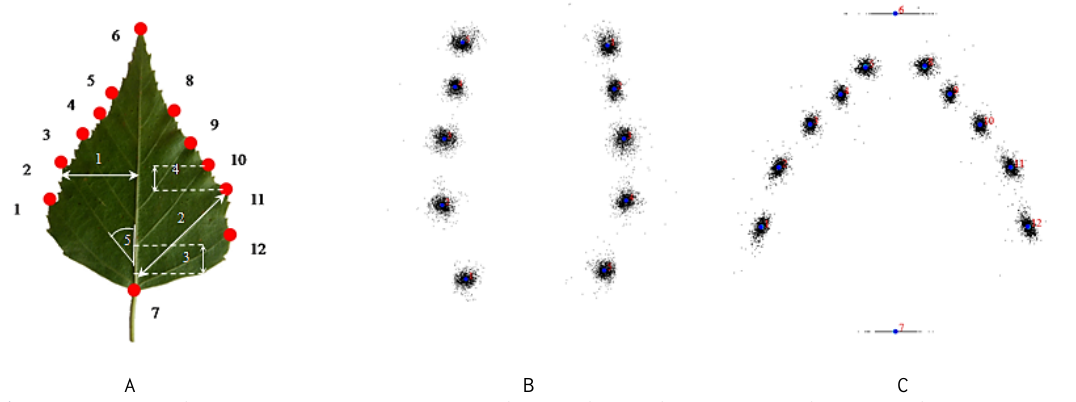
Figure 1. A: 5 pair of landmarks and metric traits: 1- half width of the leaf, 2- the length of the veins of the second order, 3- the distance between the bases of the veins, 4- the distance between the ends of the veins, 5- the angle between the midrib and lateral veins; B: Procrustes fit of left landmarks №№1 to 5, and right landmarks №№8-12; C: Procrustes fit of all amount landmarks №№1-12, asymmetry component. Black dots show the landmarks after alignment by superimposition. The matrix of asymmetry (C) reflects the variation of landmarks on the left and the right sides in overall